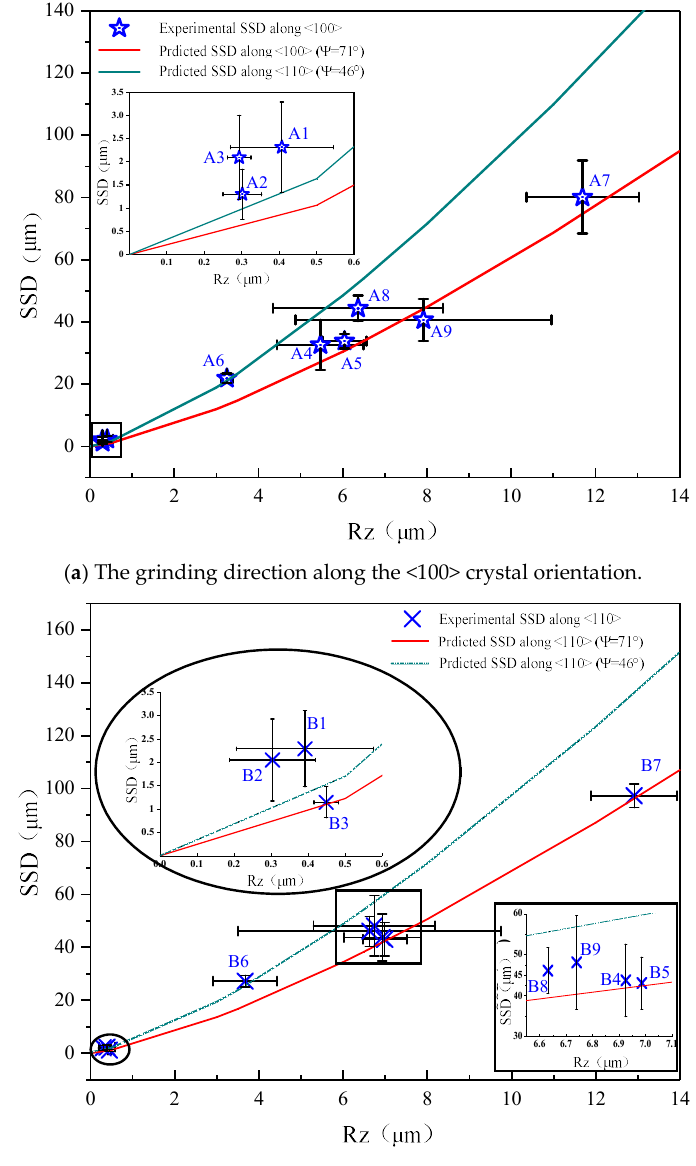
Figure 8. Comparison of experimental and predicted results.